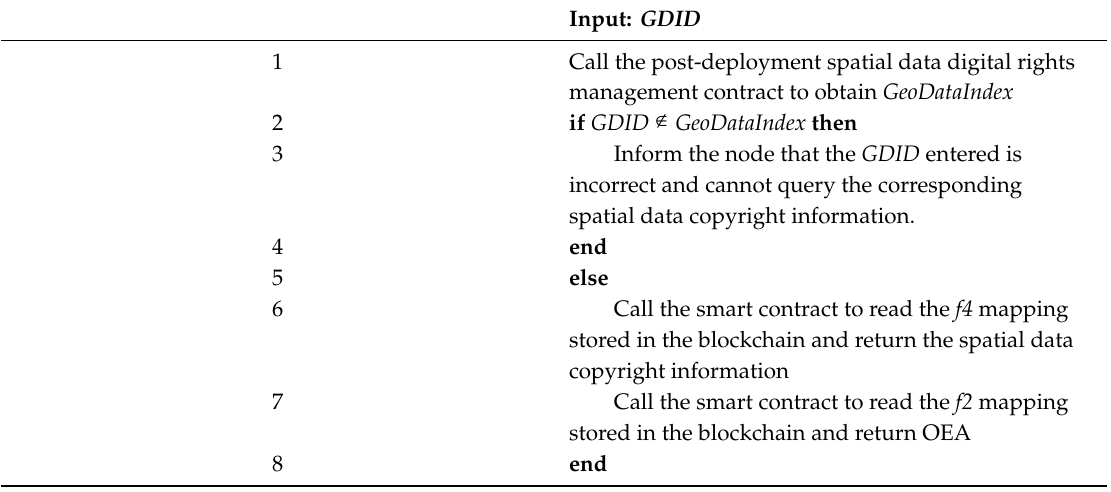
Algorithm 2. Spatial data copyright query function.